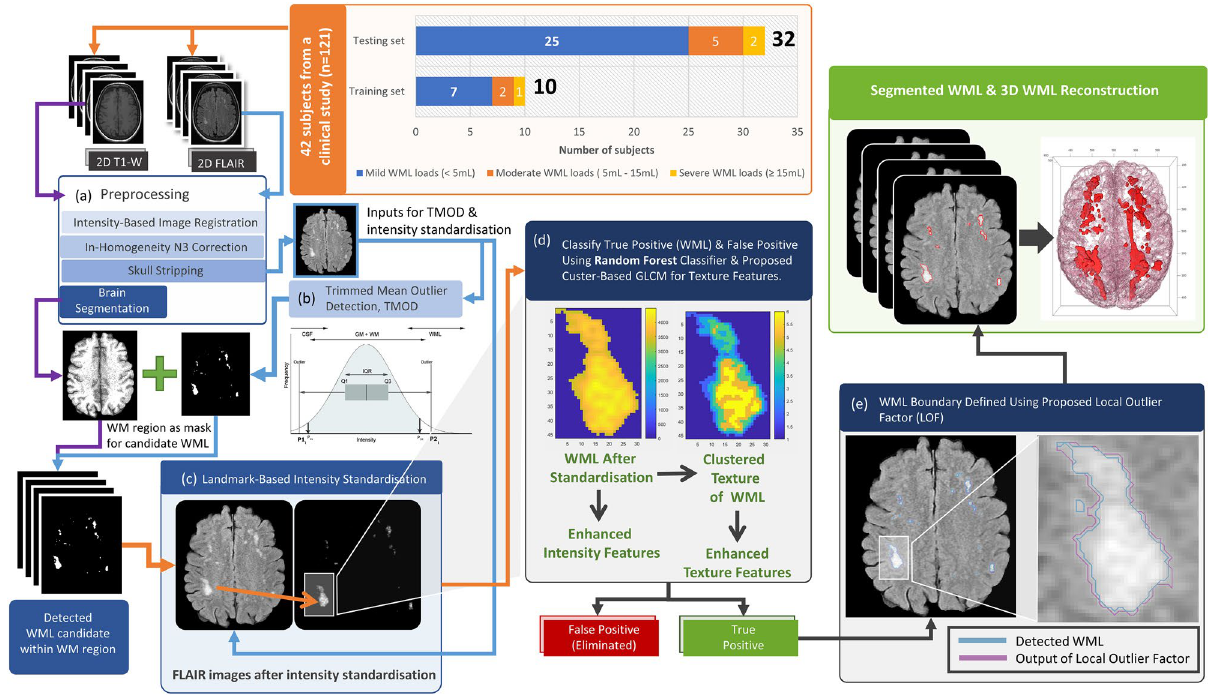
Figure 1. Flow chart of the proposed method. ( a ) The method used for image preprocessing. ( b ) The method used to detect WML candidates. ( c ) The method used for FLAIR image intensity standardization. ( d ) The method used to detect WML (true positive) from WML candidates. ( e ) Refining the boundaries of WML